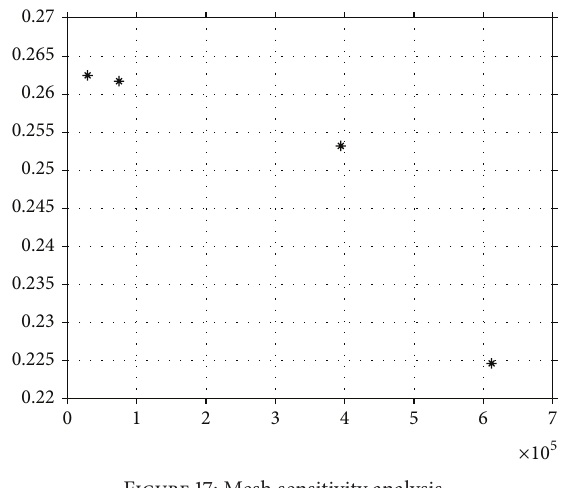
Figure 17: Mesh sensitivity